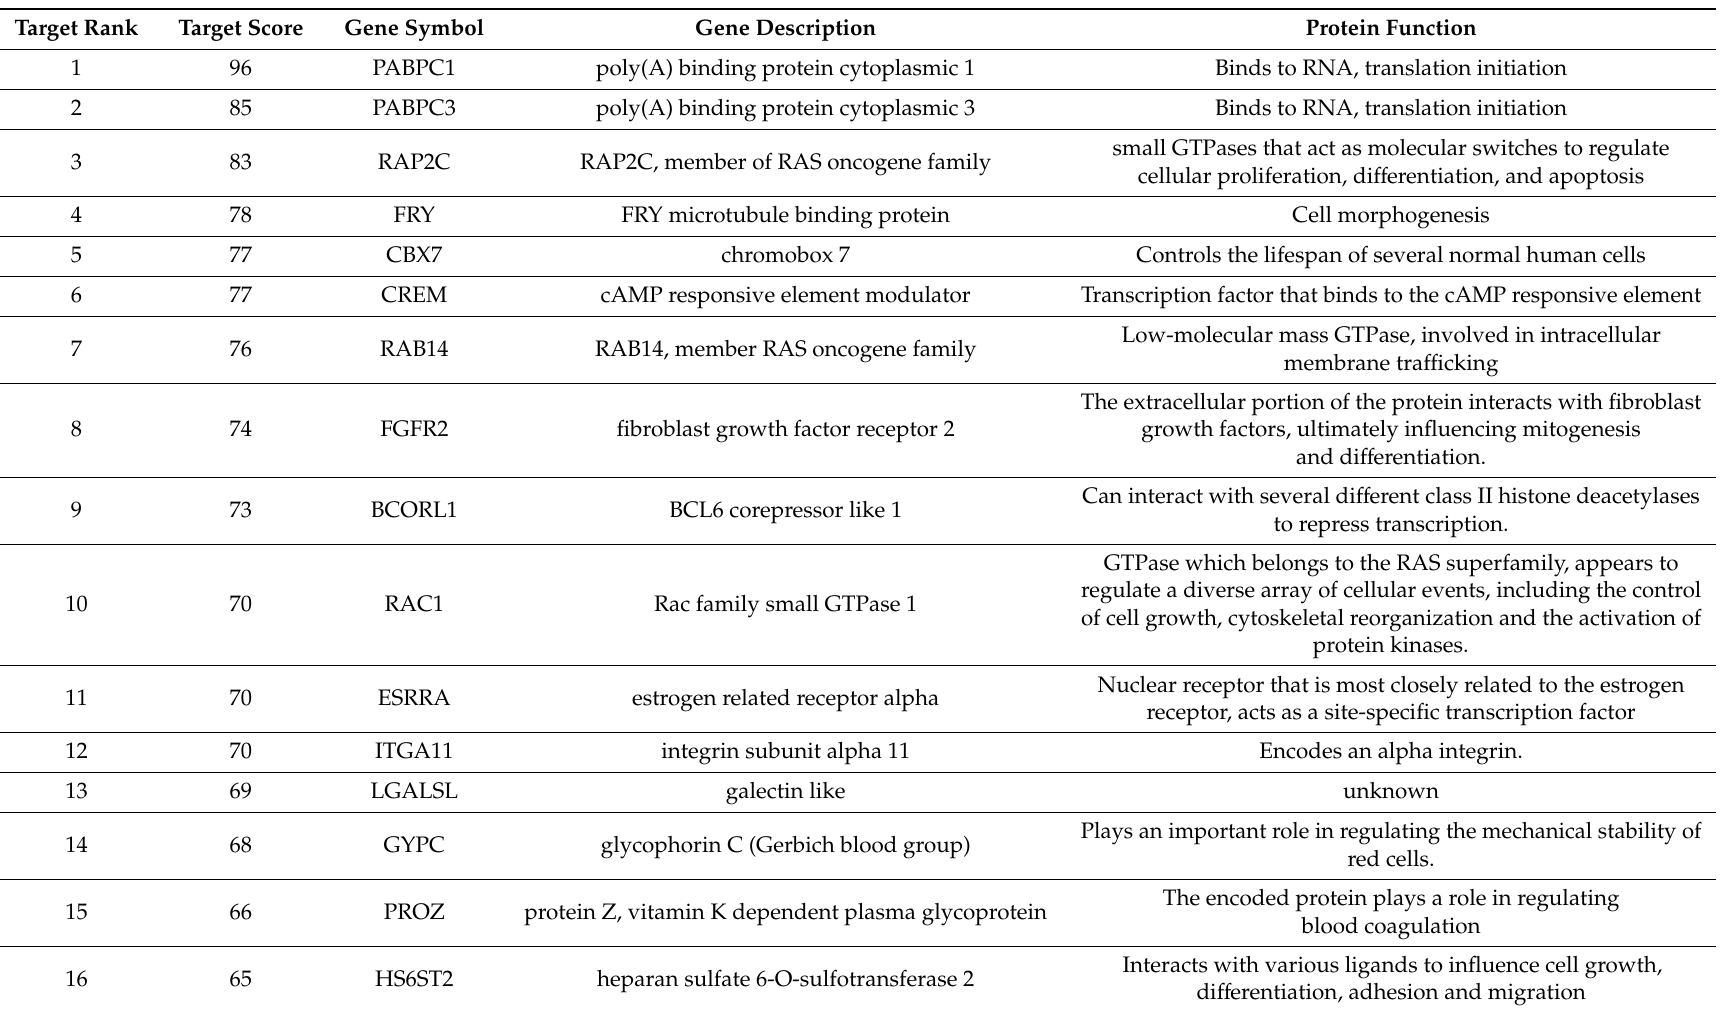
Table 3. Pathway analysis was performed using miRDB database and revealed 29 potential target genes for